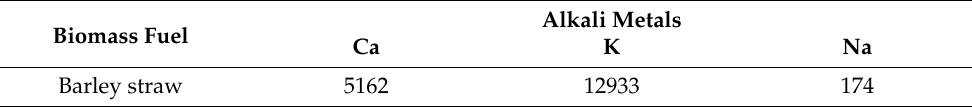
Table 3. The content of alkali metals (ppm) in the dry weight of the fuel.